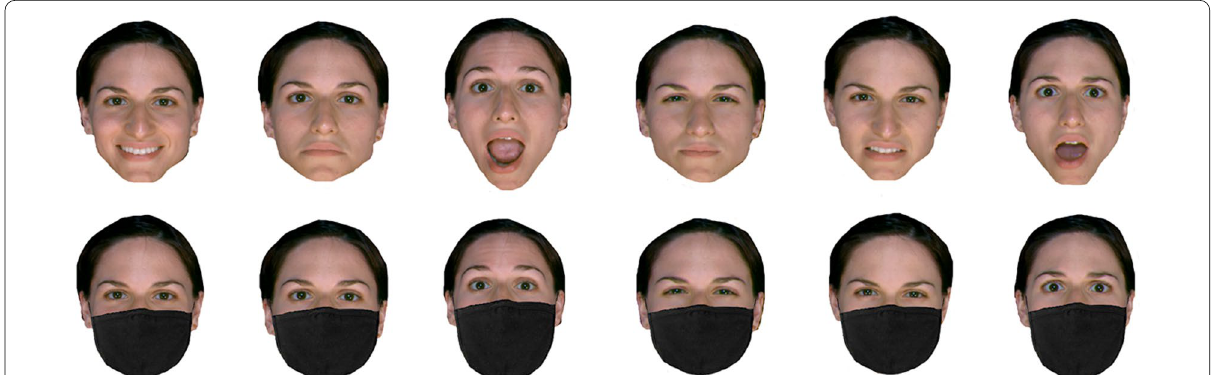
Fig. 2 Sample images from the same identity showing six different emotions without a mask (top row) and wearing a mask (bottom row). From left to right: happy, sad, surprised, anger, disgust, fear. Original photographs were taken from VISGRAF face